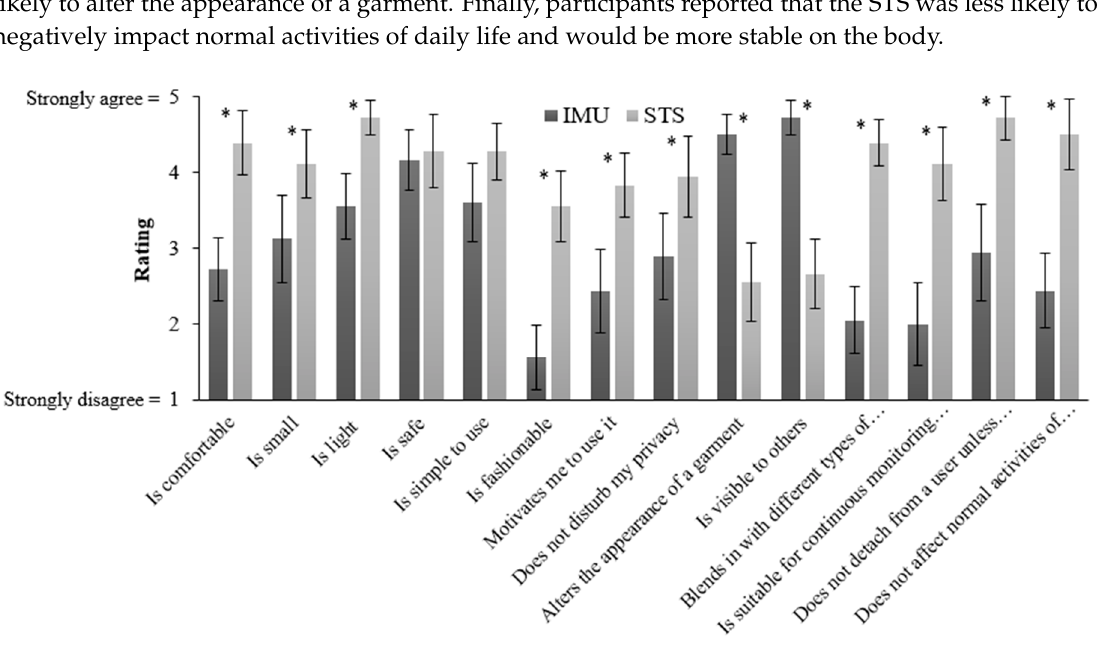
Figure 3. Mean responses to several usability questions regarding an IMU and STS. Note that * indicates a significant difference ( p < 0.01) in responses between IMUs and STS, and error bars indicate standard